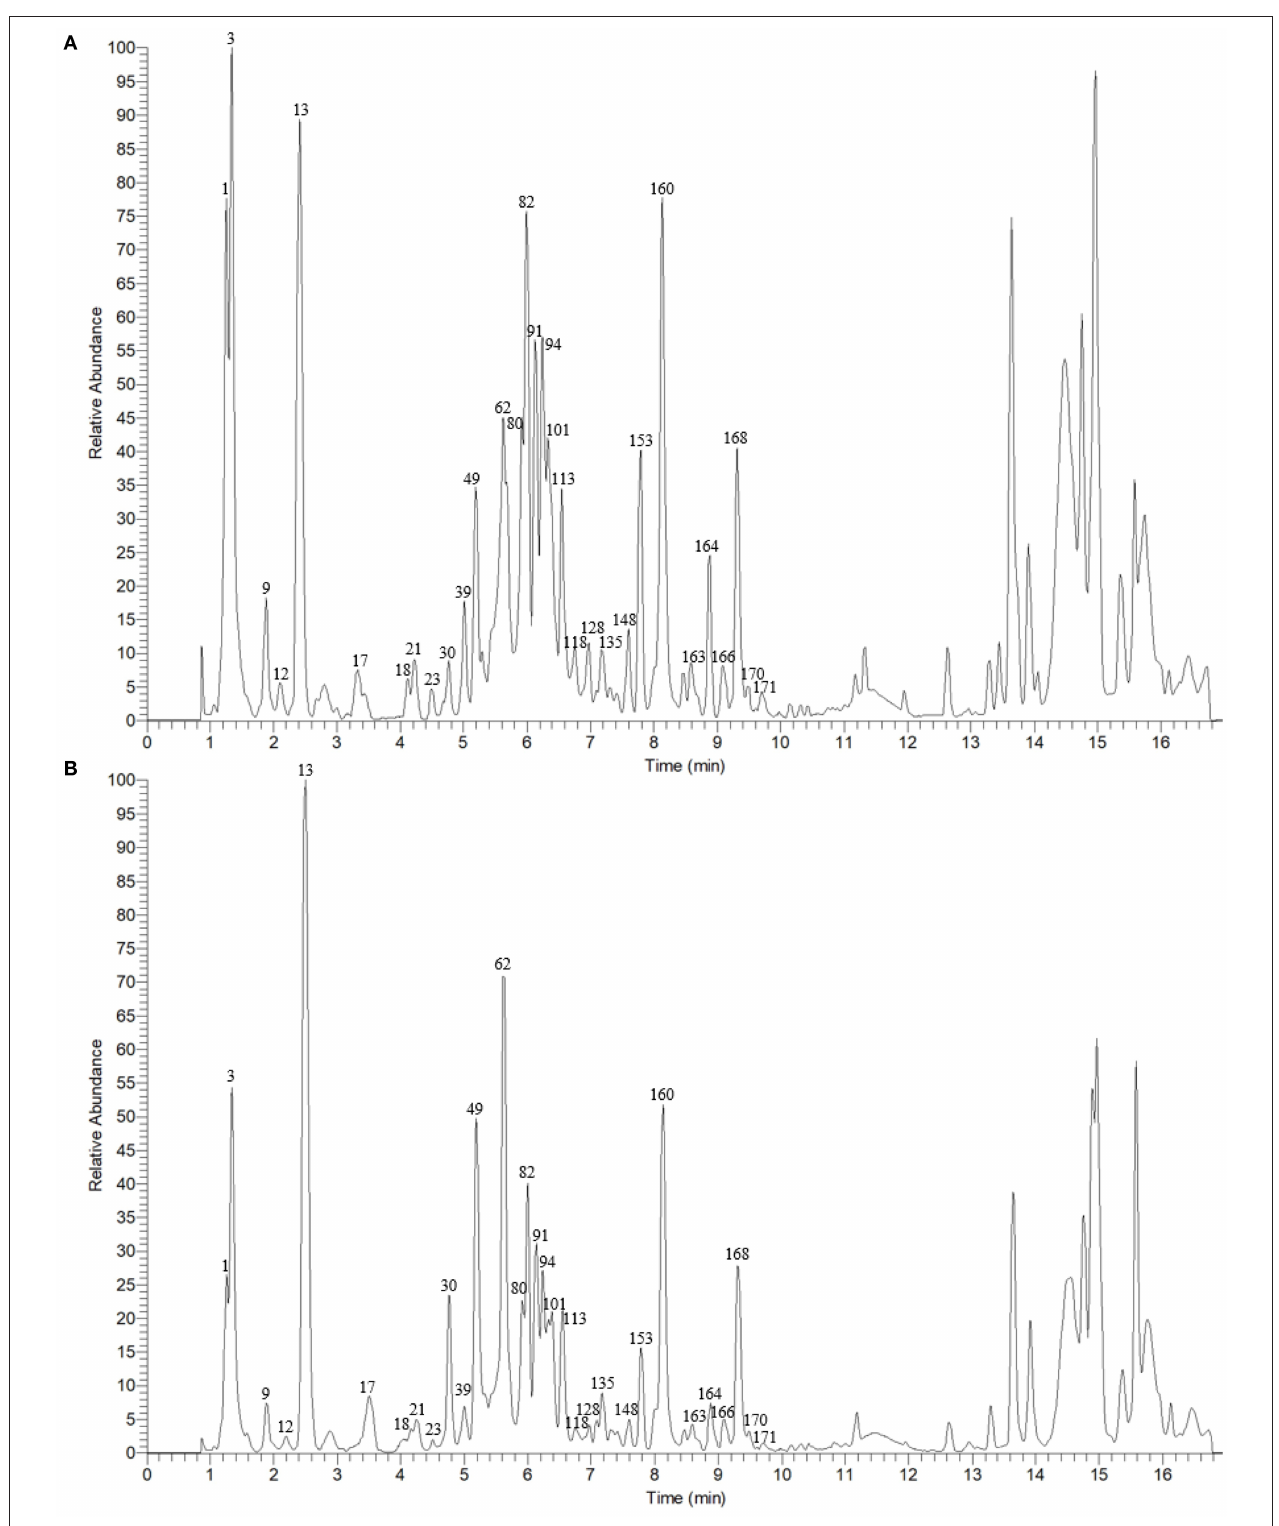
FIGURE 2 | The total ion chromatograms (TICs) of Ganpu tea (A) and Pu-erh tea (B) in negative ion mode.